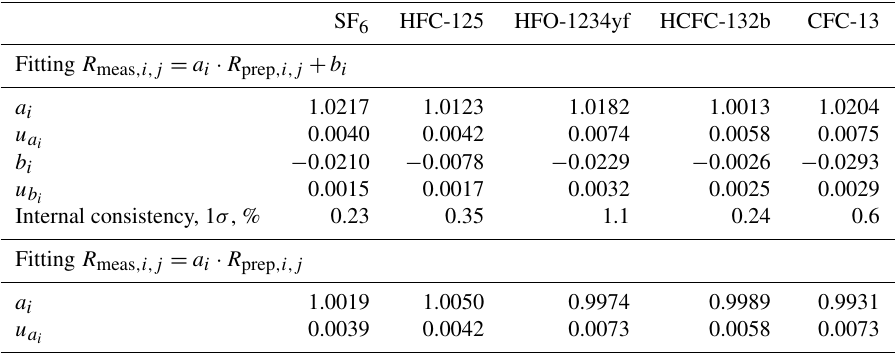
Table 4. Correcting the measured ratio: results of weighted linear fitting and calculated internal consistency within the METAS-2017 suite of reference gas mixtures, for each substance. Values correspond to calculations done after exclusion of the